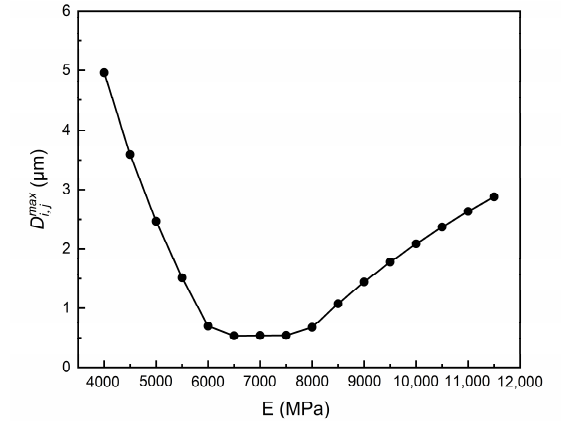
Figure 8. The relationship between the minimum value of 𝐷 (cid:3036),(cid:3037)(cid:3040)(cid:3028)(cid:3051) and the equivalent elastic mod-